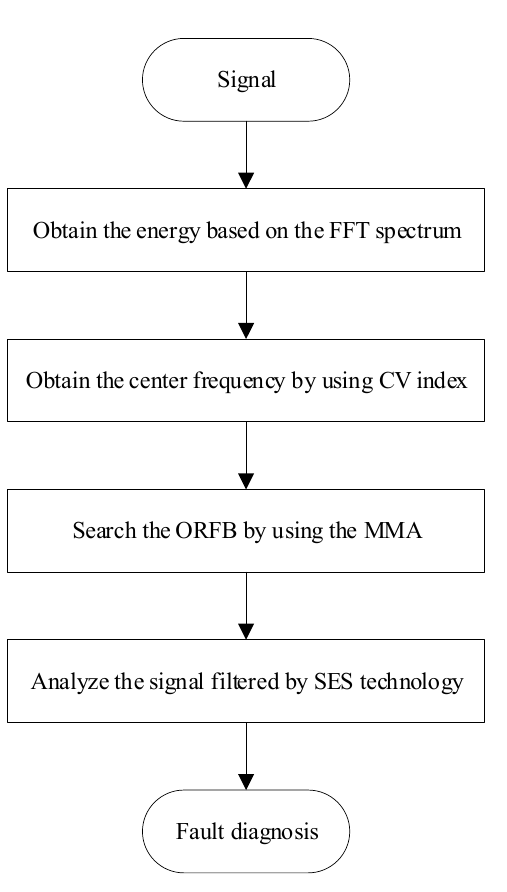
Figure 5. The initial center frequency-guided filter (ICFGF) flowchart.